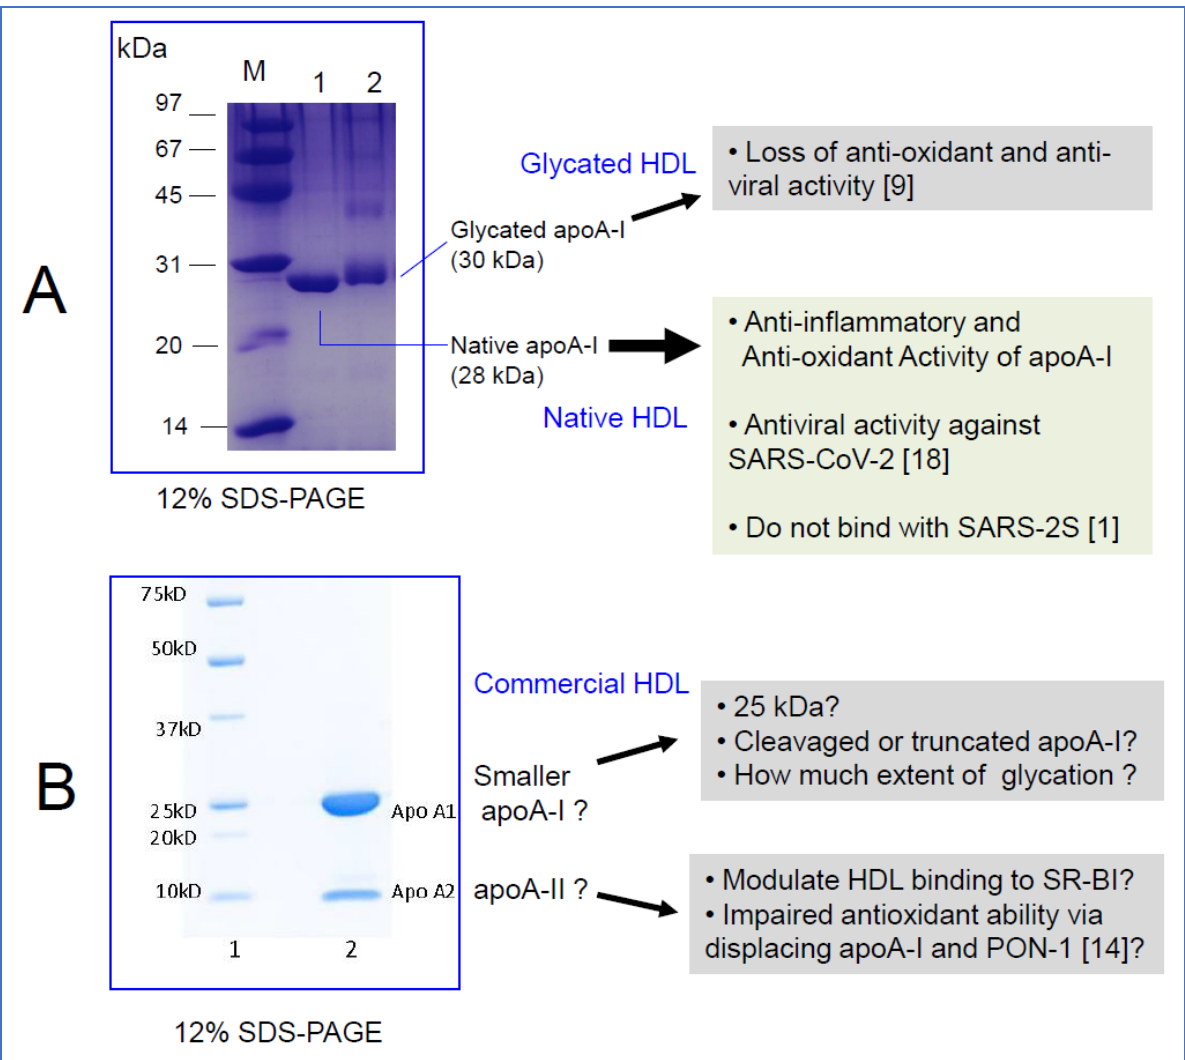
Figure 1. Different properties of apoA-I and apoA-II in HDL from different sources. Image of SDS-PAGE stained by Coomassie blue. ( A ) Electrophoretic patterns of native HDL (lane 1), purified from healthy and young Korean subjects by sequential ultracentrifugation. Glycated HDL (lane 2) was fructosylated for 72 h. M, molecular weight standard (Bio-Rad, low range, Cat # 1610304). ( B ) Electrophoretic patterns of commercial HDL (Sigma L8039, lot # SLCF0413). This gel photograph (12% Tris-Glycine gel, Invitrogen cat # XP00120) was courteously provided by Research & Applied Solutions of Merck/Sigma-Aldrich with permission. Lane M, molecular weight standard. Precision Plus Protein Unstained Standards (Bio-Rad cat # 161-0363).